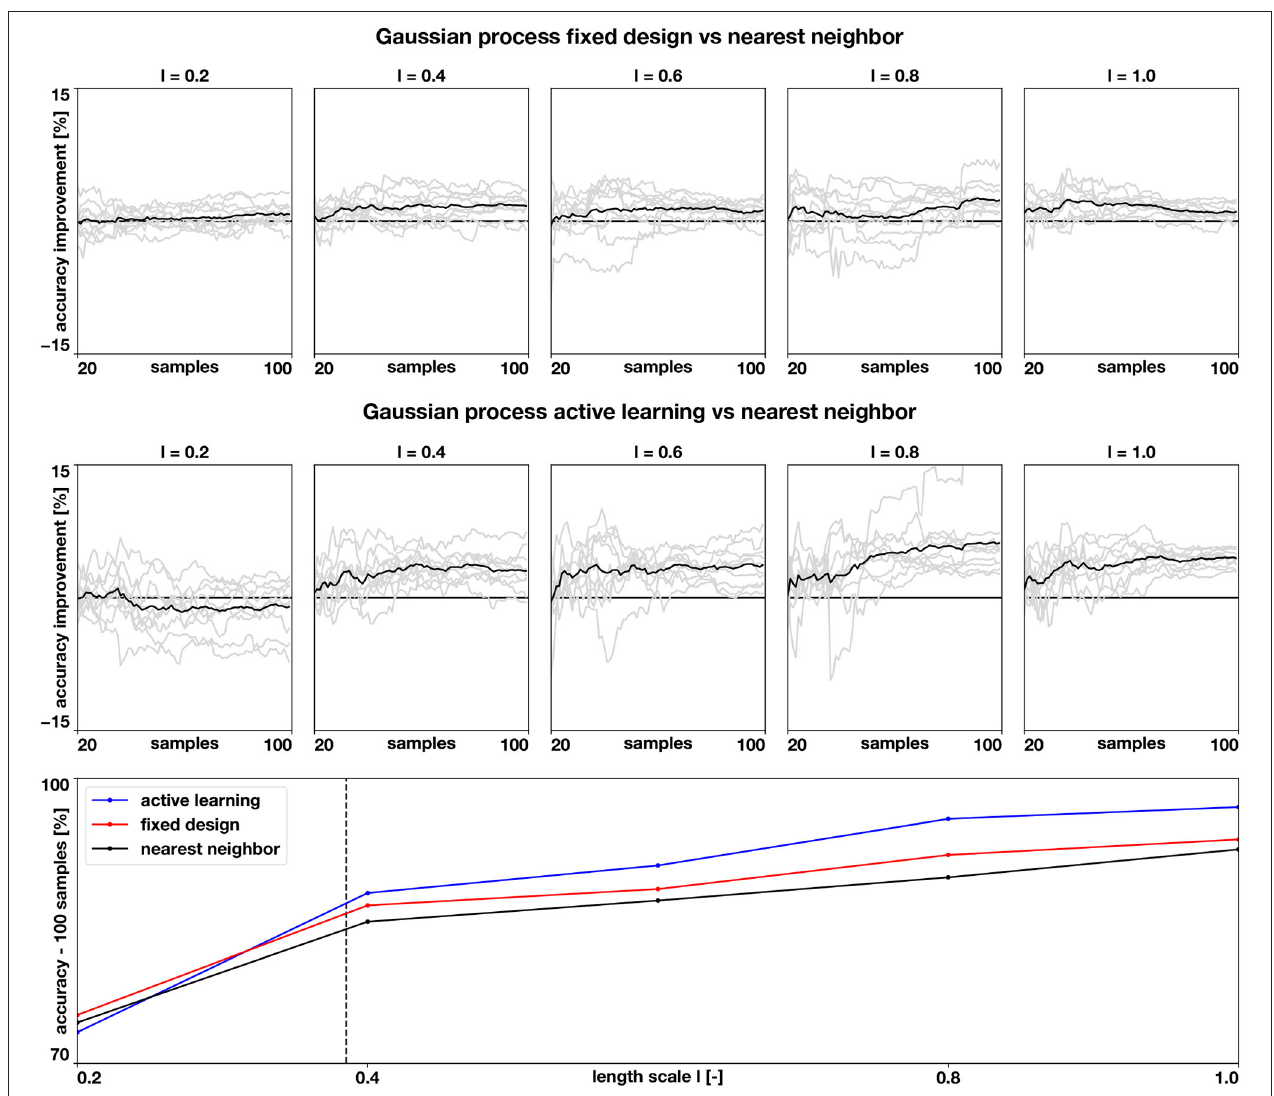
FIGURE 5 | Accuracy of the numerical assessment. We quantify the improvements in accuracy when using a Gaussian process classifier versus the nearest neighbor classifier (top row) and when using a Gaussian process classifier with active learning, versus the baseline nearest neighbor classifier (middle row) for different length scales. The gray lines show the balanced accuracy improvements of the 10 examples for each length scale and the black line shows the mean improvement. The bottom row shows how the average balanced accuracy changes with length scale when the classifiers are trained with 100 samples. The dashed vertical line represents the average geodesic distance between training points of the fixed